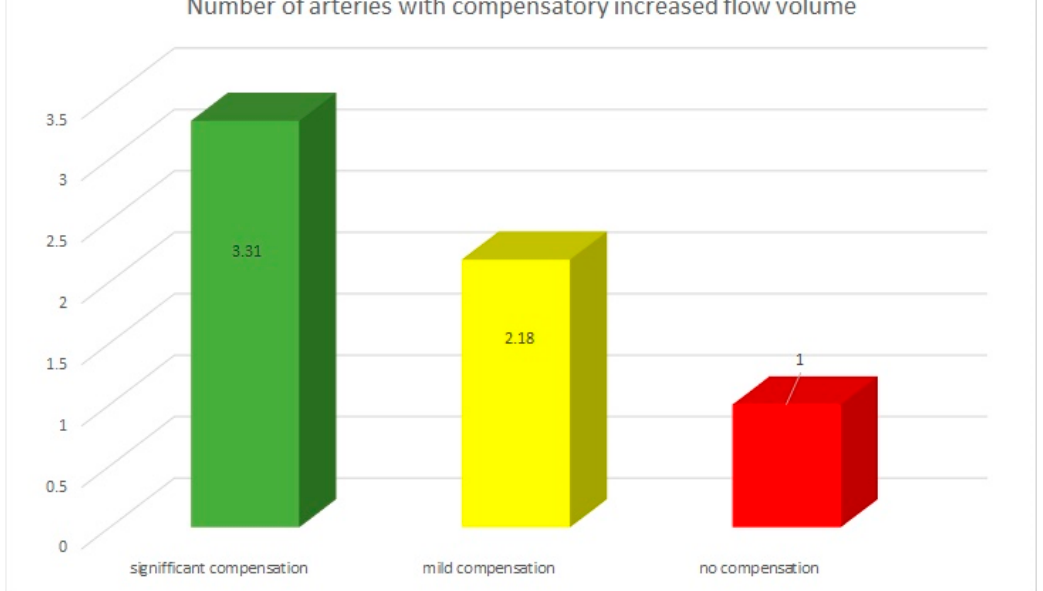
Figure 5. Average number of arteries with compensatory increased flow volume involved in the volumetric flow compensation. In the “significant compensation group” the compensatory elevated blood flow volume was observed in 3.31 vessels, in the “mild compensation” group in 2.18 vessels, and in the “no compensation” group only in 1 vessel.